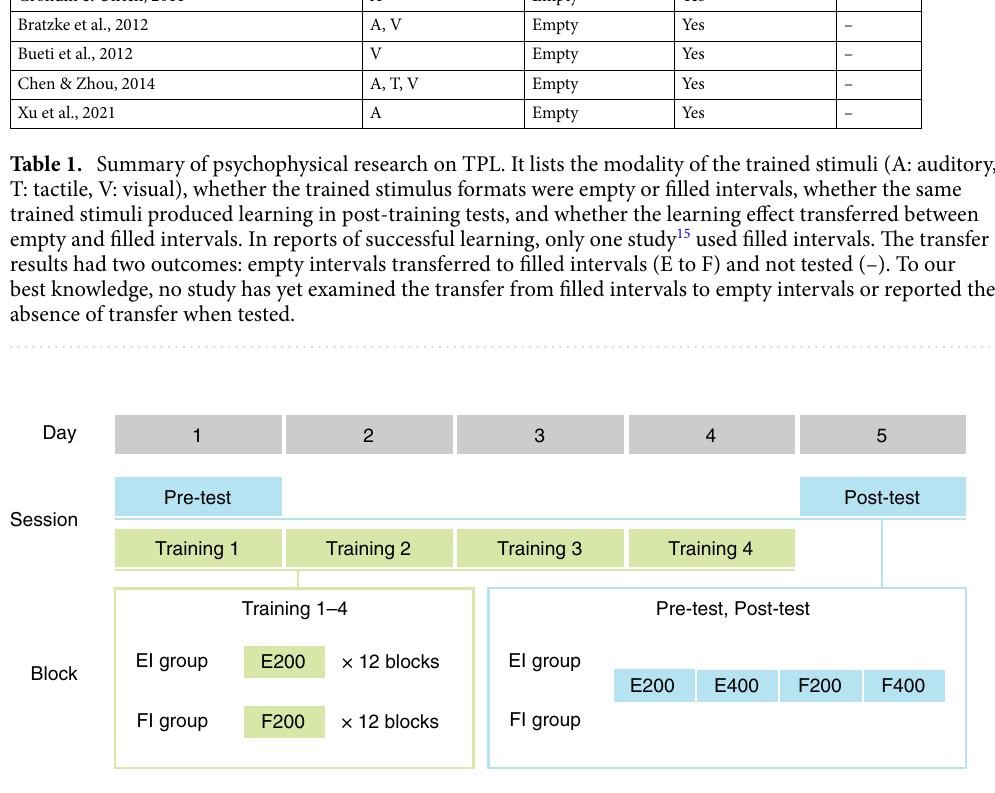
Figure 1. The experimental schedule. The empty-interval (EI) group and the filled-interval (FI) group shared the same pre- and post-tests including four blocks: empty-200 ms (E200), empty-400 ms (E400), filled-200 ms (F200), and filled-400 ms (F400). Across the training sessions, the EI group was trained to discriminate empty- 200 ms intervals, and the FI group practiced with filled-200 ms intervals for 12 blocks per